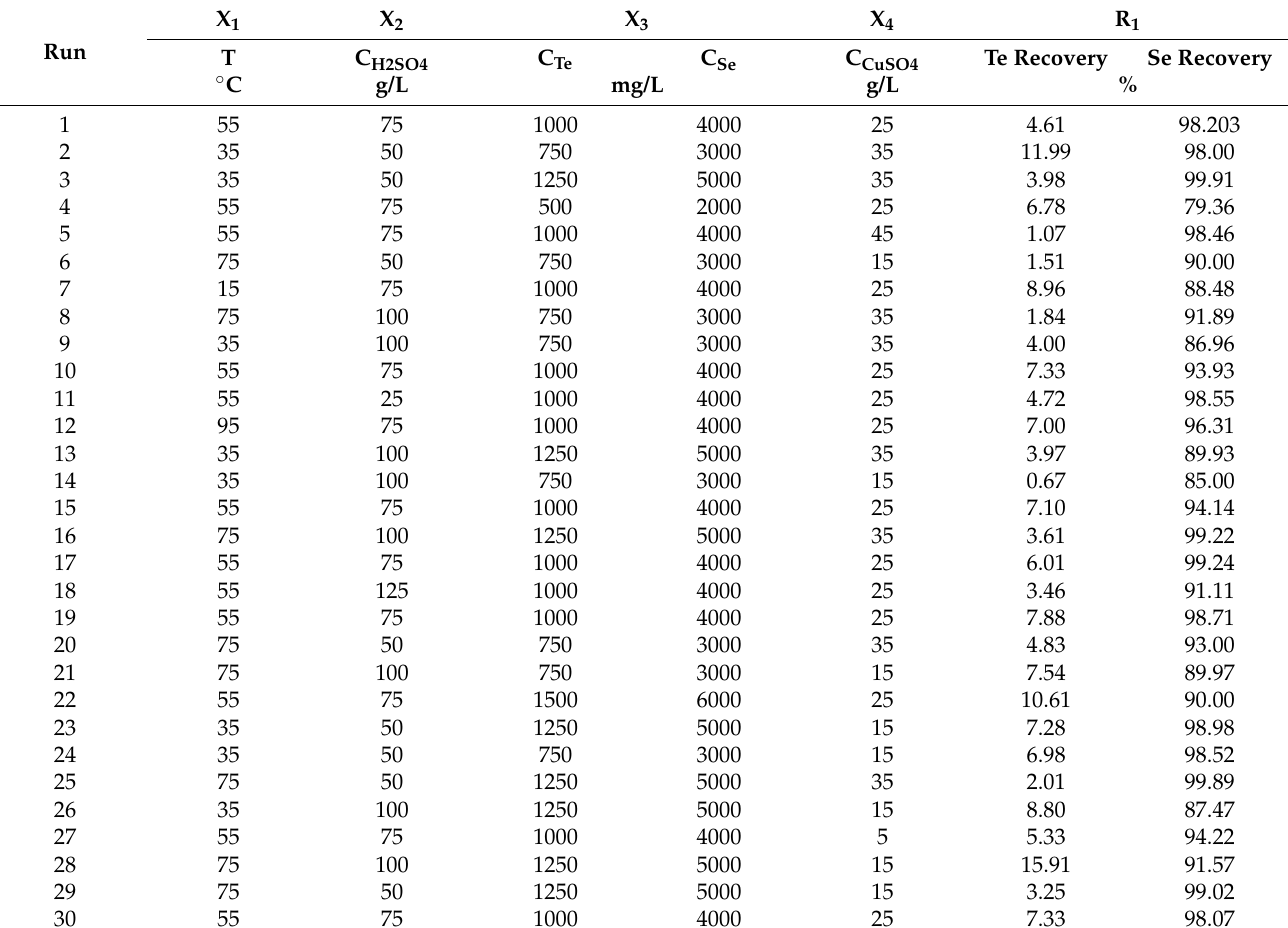
Table 3. Design matrix for CCD experiments and